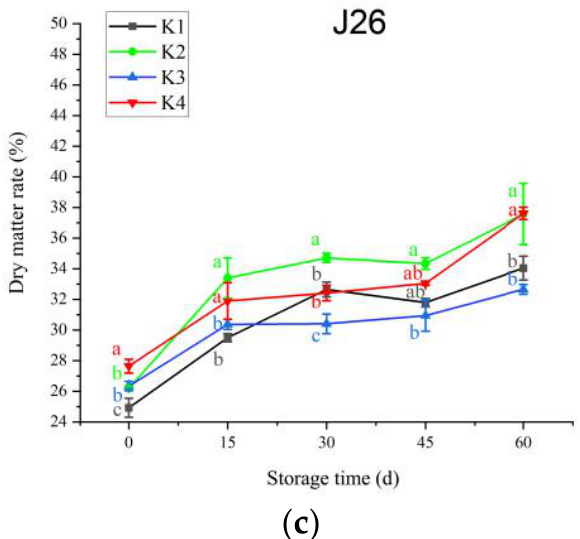
Figure 3. Dry matter rate of the tuberous root of different UCZ treatments during storage. ( a ) Z13; ( b ) Z33; ( c ) J26. Values within the same storage day followed by the same letter are not significantly different at the 5% level according to ANOVA- Duncan’s multiple range test. K1: Normal basal fertilizing without UCZ; K2: Normal basal fertilizing with UCZ; K3: Rich basal fertilizing without UCZ; K4: Rich basal fertilizing with UCZ.